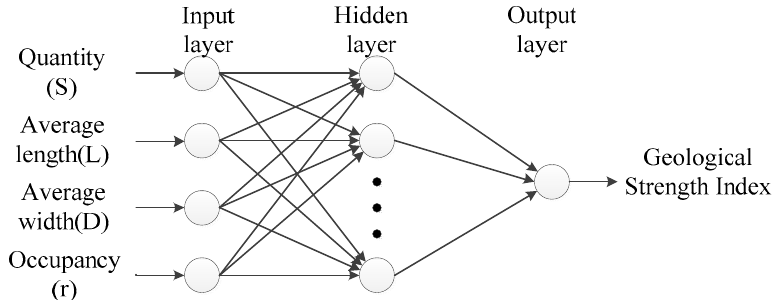
Figure 3. Design of artificial neural network.